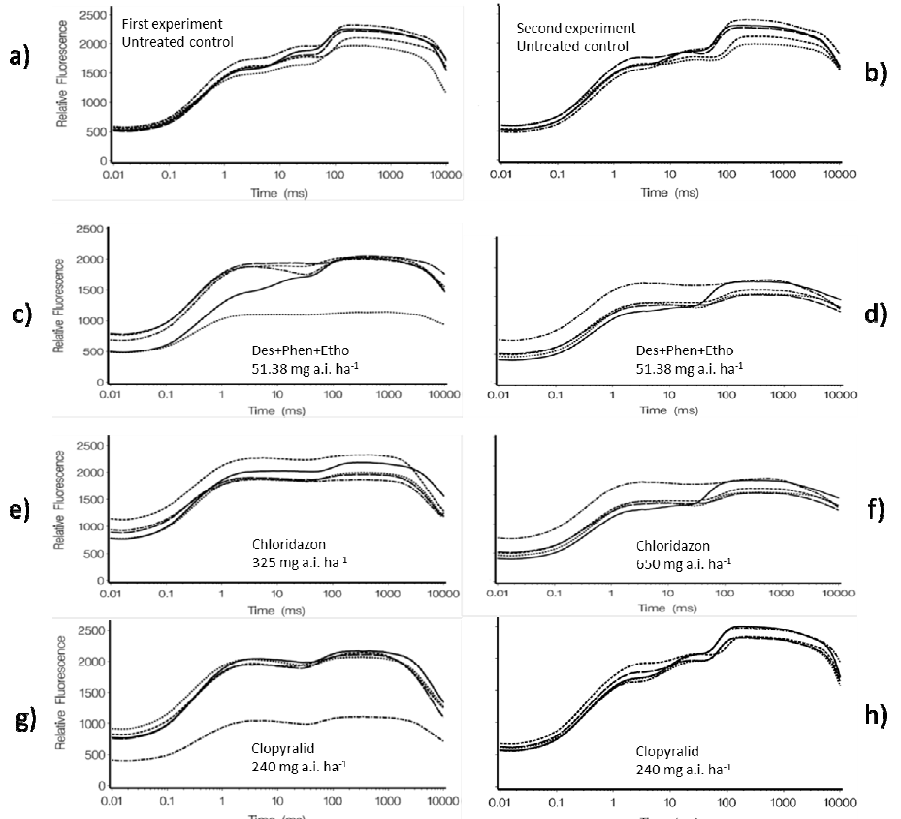
Fig. 2. Effect of herbicides application on the shape of the Kautsky curve. Kautsky curve for untreated plants of Amaranthus retroflexus (a) and Portulaca oleracea (b), Des + Phen + Etho effects on A. retroflexus (c) and P. oleracea (d) at 51.38 mg a.i. ha -1 . Chloridazon effects on A. retroflexus (e) and P. oleracea (f) at 326 and 650 mg a.i. ha -1 respectively, A. retroflexus (g) affected and P. oleracea (h) unaffected at 240 mg a.i. ha -1 by clopyralid. Each curve is the mean of twelve replications for untreated controls and four replications for rest of the doses. Des + Phen + Etho = Desmedipham + phenmedipham + ethofumesate; HAS value is mean hours after